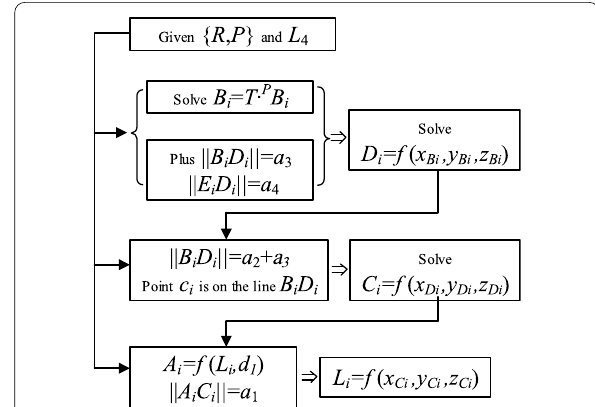
Figure 2 The inverse kinematics solution process of the